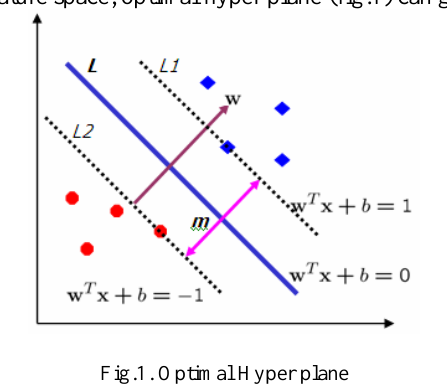
Fig.1. Optimal Hyper